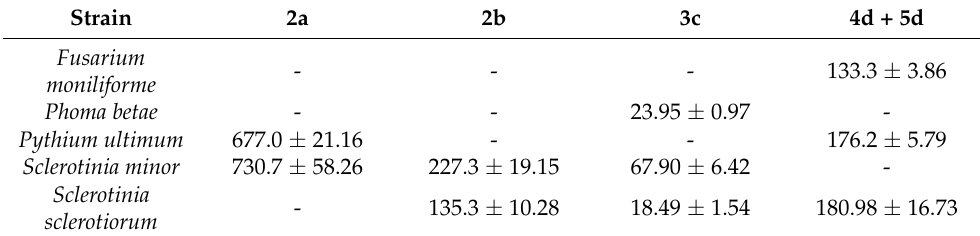
Table 5. IC 50 values of secosteroids for selected fungi expressed in µ g/mL.